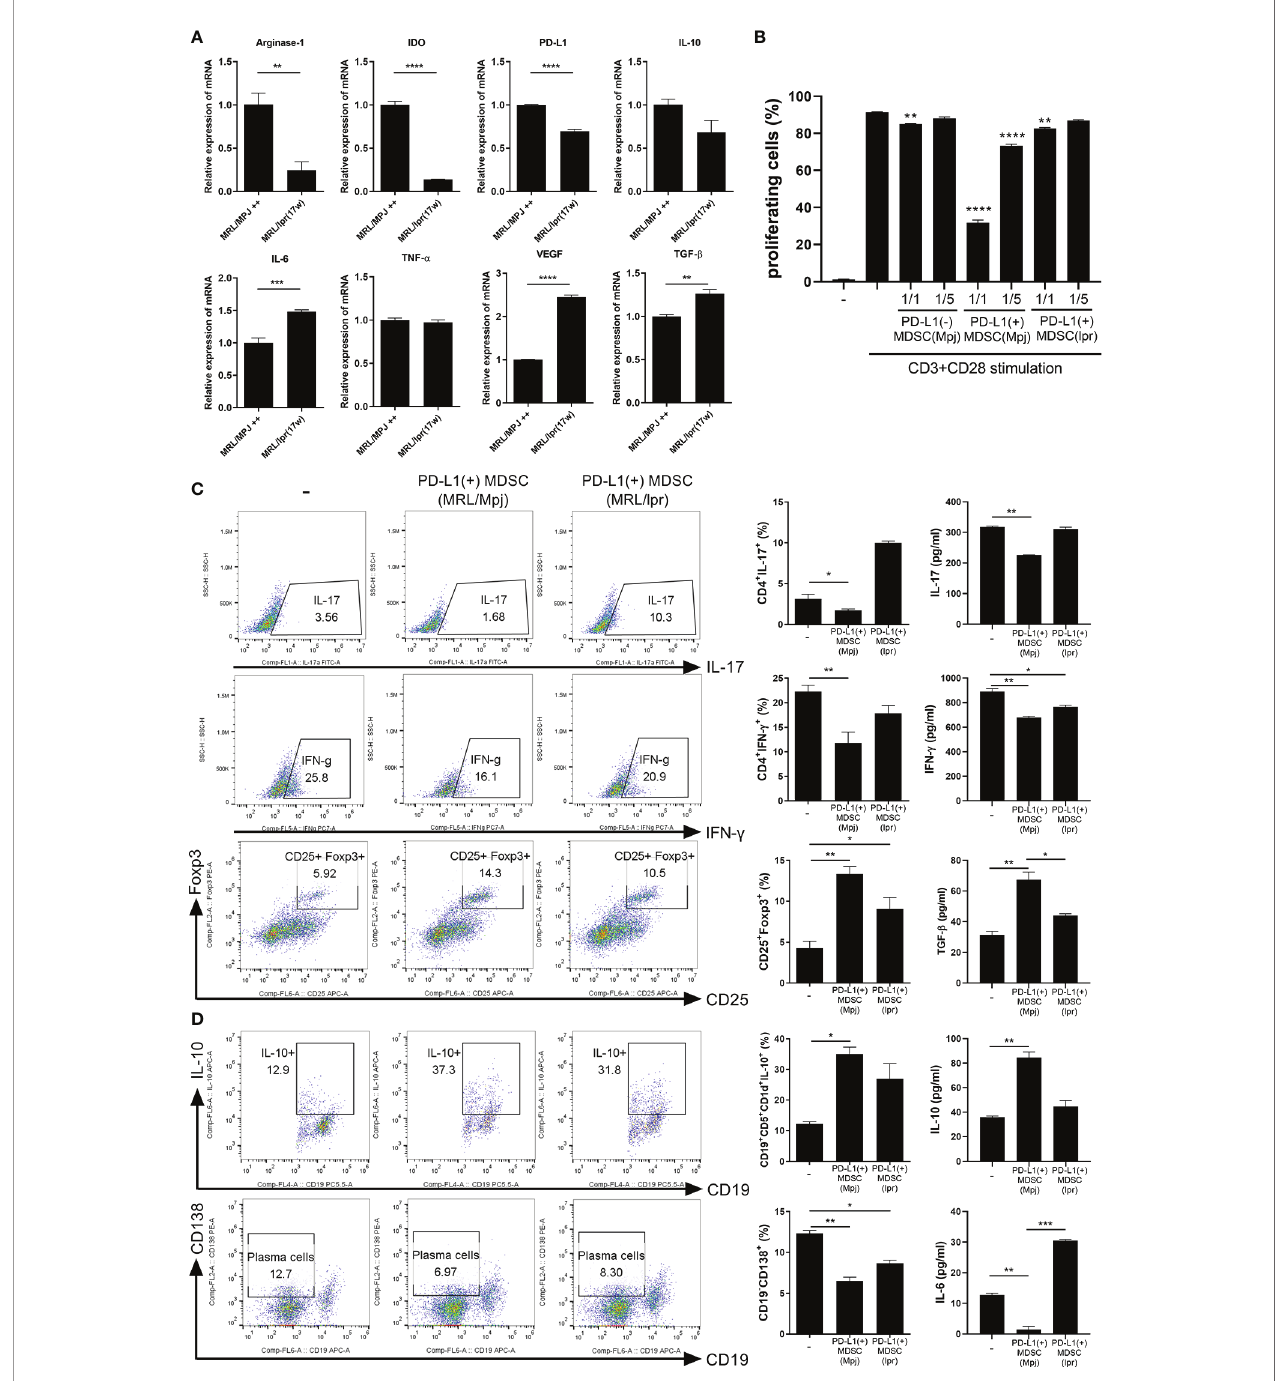
FIGURE 2 | PD-L1 expressing MDSCs from control mice shows more powerful immune regulatory activity in vitro . (A) PD-L1 positive MDSCs from lupus prone MRL/ lpr mice and MLR/MpJ (control mice) were isolated. The mRNA levels of pro or anti-in fl ammatory molecules were determined. (B) CD4+ T cells (5 × 10 5 ) from MLR/ lpr mice were labeled with Cell trace violet, and cultured with/without PD-L1 positive or negative MDSCs (1:1, 5:1 ratio). The percentage of proliferating CD4+ cells were analyzed. (C) CD4+ T cells from MLR/ lpr mice were cultured with PD-L1 positive MDSCs from MRL/ lpr mice and MLR/MpJ (1:1 ratio) in the presence of anti-CD3 (0.5 m /ml). After 3 days, cells were analyzed for Th17, Th1 and Treg cells by fl ow cytometry. The percentage of each cell population are shown in the right panel. The concentrations of IL-17, IFN- g and TGF- b in supernatant were measured by ELISA. (D) Splenocytes from MLR/ lpr mice were cultured with PD-L1 positive MDSCs (1:1 ratio) in the presence of LPS (100 ng/ml). After 3 days, cells were analyzed for IL-10 producing B10 cells and plasma cells (CD19-CD138+) by fl ow cytometry. The percentage of each cell population are shown in the right panel. The concentrations of IL-10 and IL-6 in supernatant were measured. Data are expressed as the mean ± SEM. Data are representative of three independent experiments (* P < 0.05, ** P < 0.01, *** P < 0.001, **** P <